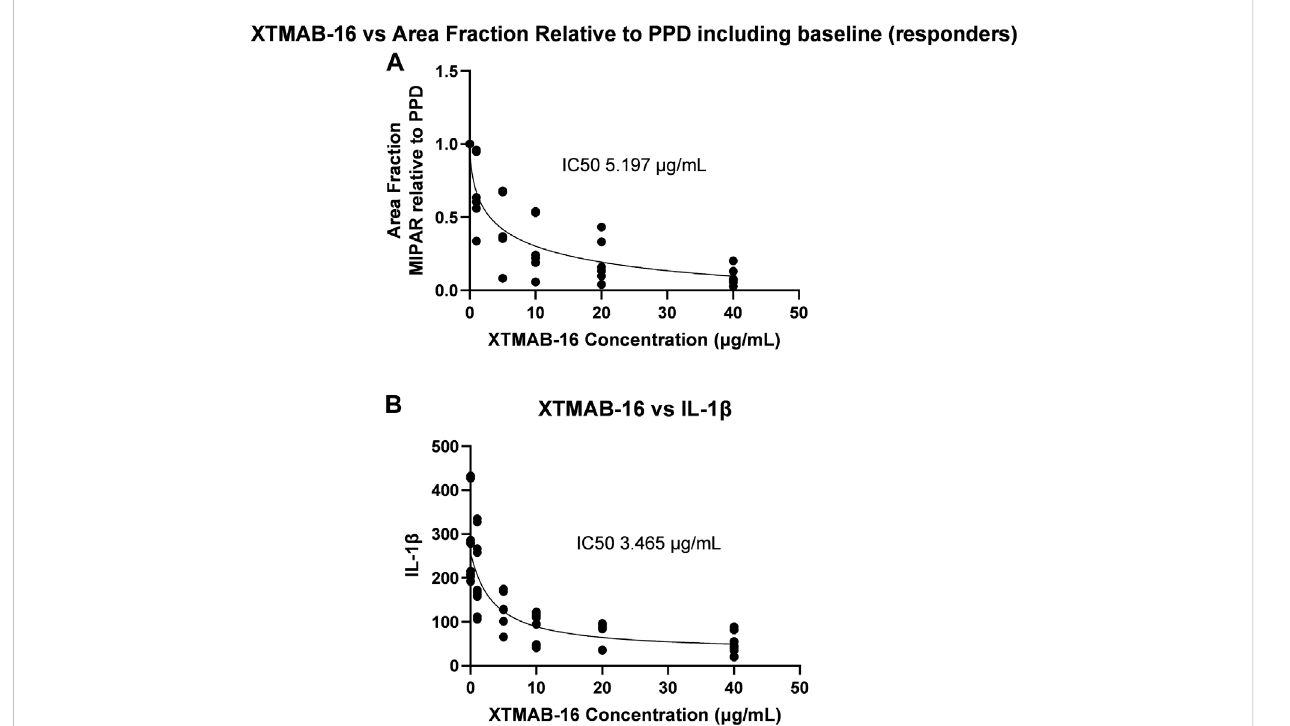
FIGURE 3 XTMAB-16 Concentration Versus Area Fraction (A) and IL-1 β (B) in the In Vitro Granuloma Model. Note: The 95% CI was not estimated because the software was unable to calculate a complete CI. Abbreviations: CI = con fi dence interval; IC 50 = half maximal inhibitor concentration; IL = interleukin; PPD = puri fi ed protein